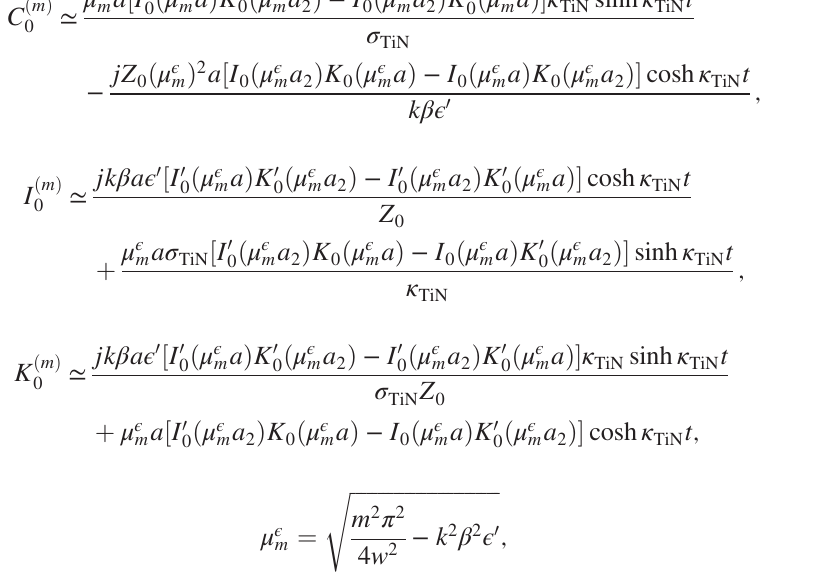
ffiffiffiffiffiffiffiffiffiffiffiffiffi ffiffiffiffiffiffiffiffiffiffiffiffiffiffiffiffiffiffiffi